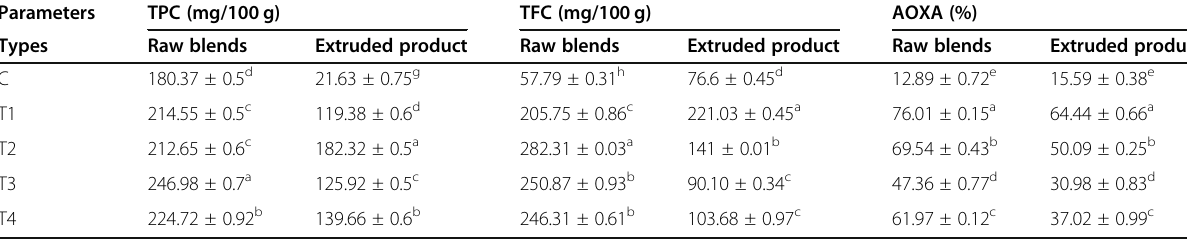
Table 6 Different functional properties of raw blends and extruded products Parameters